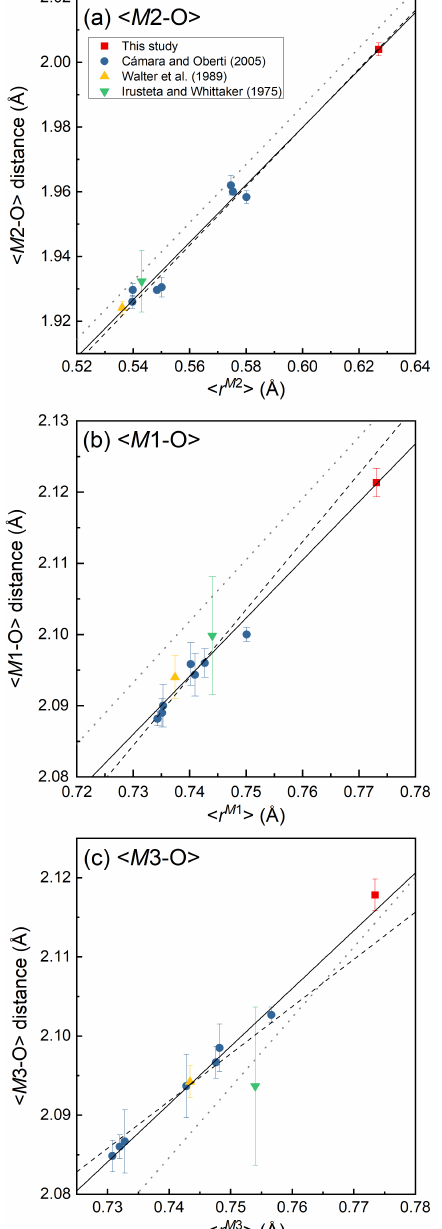
Figure 4. Variations of <M 2–O > (Å) (a) , <M 1–O > (Å) (b) and <M 3–O > (Å) (c) against mean ionic radius (Å), <r> , of